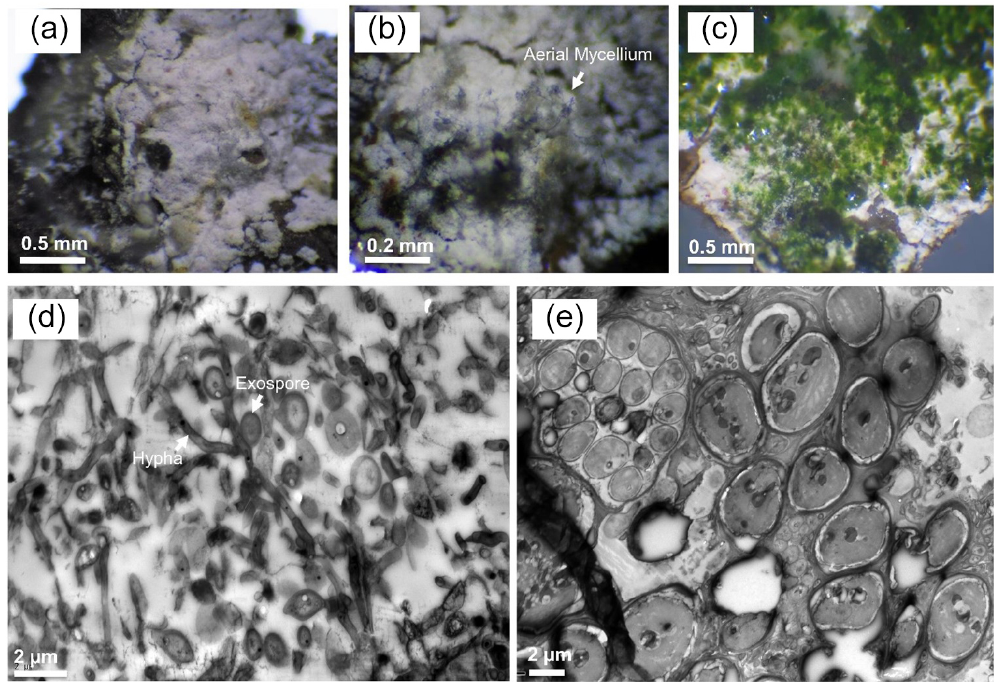
Figure 6. Light and transmission electron microscopy of Marsberg Kilianstollen leachate group biofilms. The images (a–c) captured under the light microscope depict the aerial mycelium and green algal biomass along with the white bacterial biofilm. TEM micrographs (d) and (e) show the mycelial growth and spores formed at short branches along a hypha resembling Ktedonobacteria sporulation pattern (hypha and exospore are marked in d ) and the large eukaryotic algal cells (e) ,